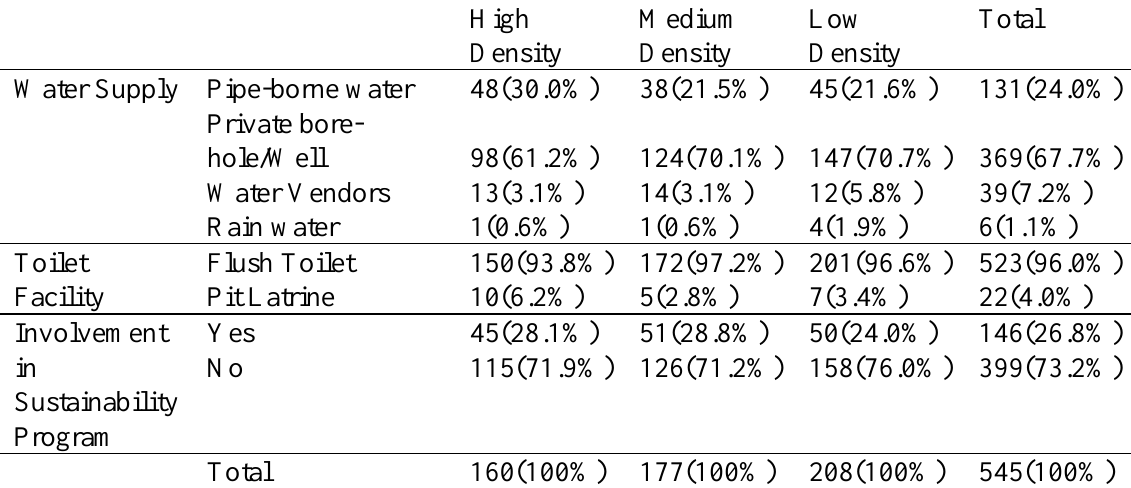
Table 4. Frequency distribution of Respondents’ type of toilet facility, mode of water supply and sustainability